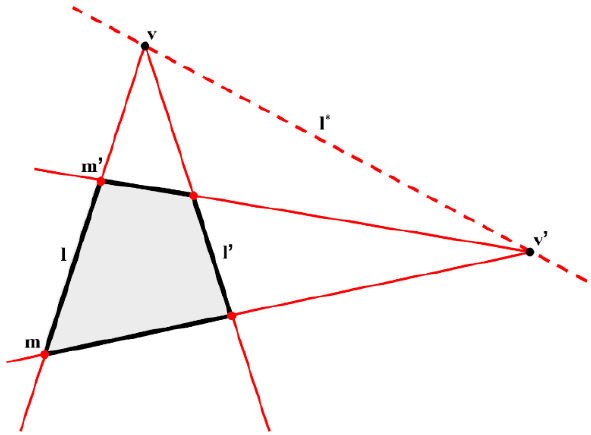
Figure 3. The procedure used for metric rectification with two sets of parallel lines and the focal length.